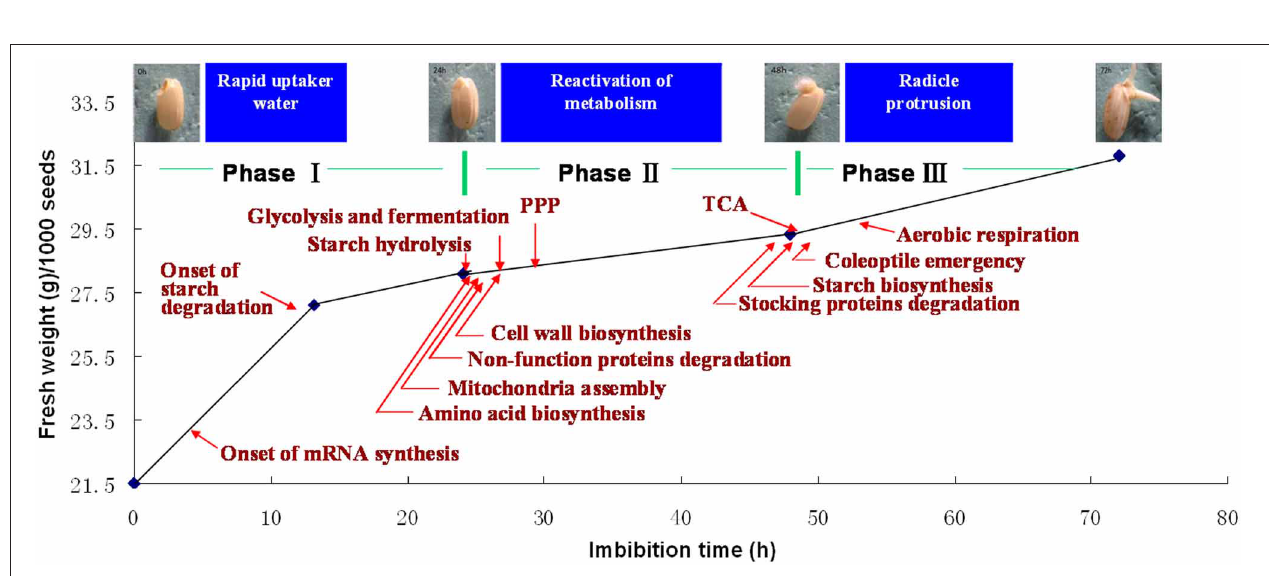
seed germination obtained progress on multi-level, future directions will focus on the intensive studies of protein interaction, protein biomarker screening, PTMs, individual protein function analysis, and bioinformation integration.